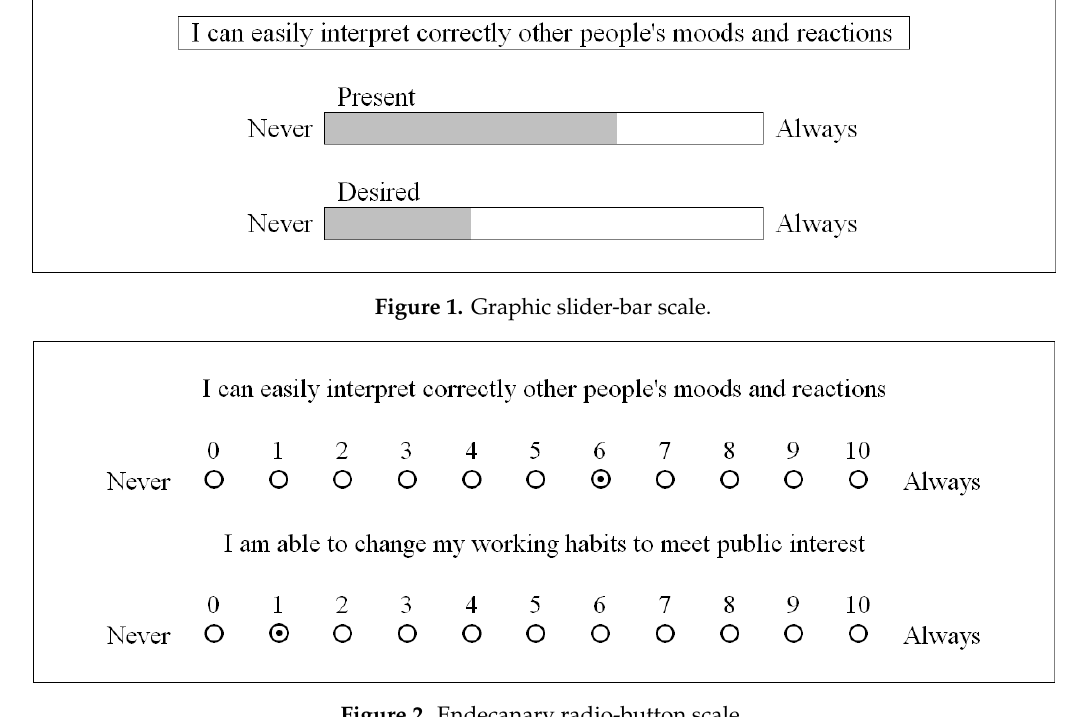
Figure 2. Endecanary radio-button scale.